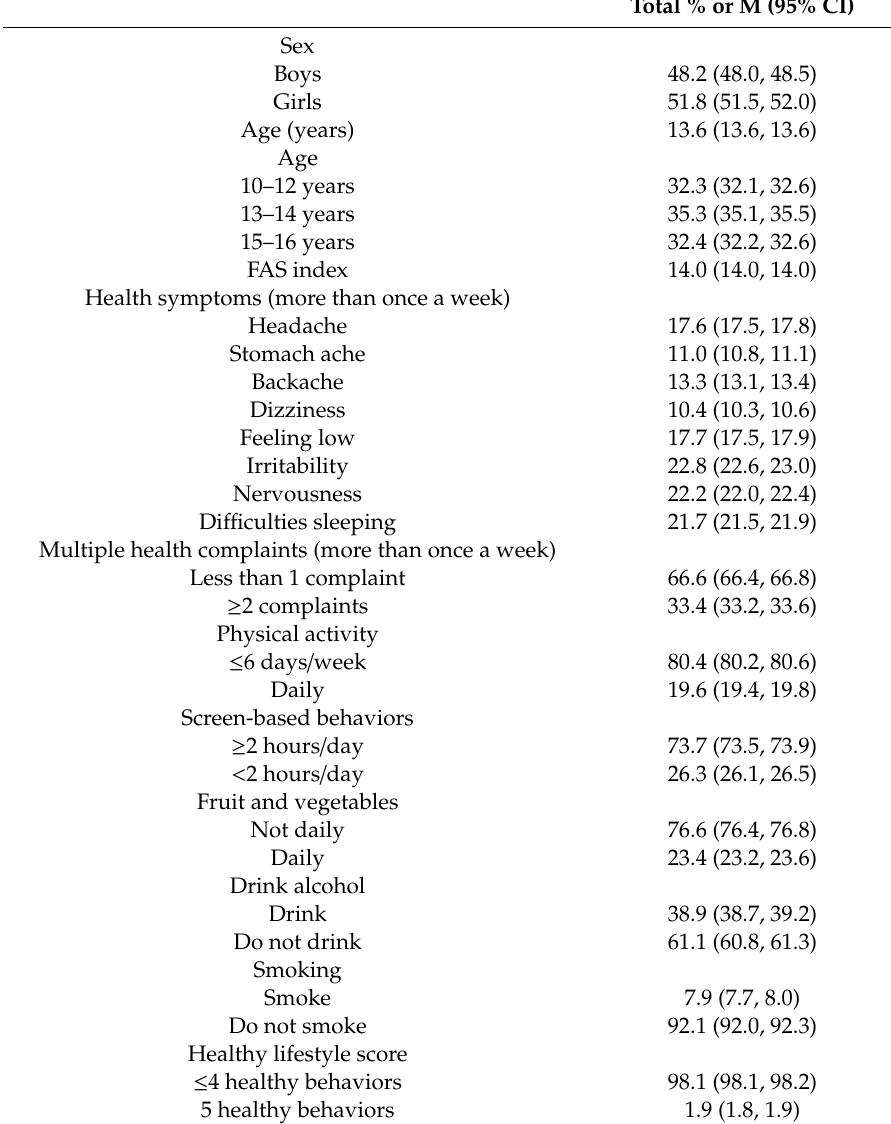
Table 1. Participants’ characteristics (n = 167,021